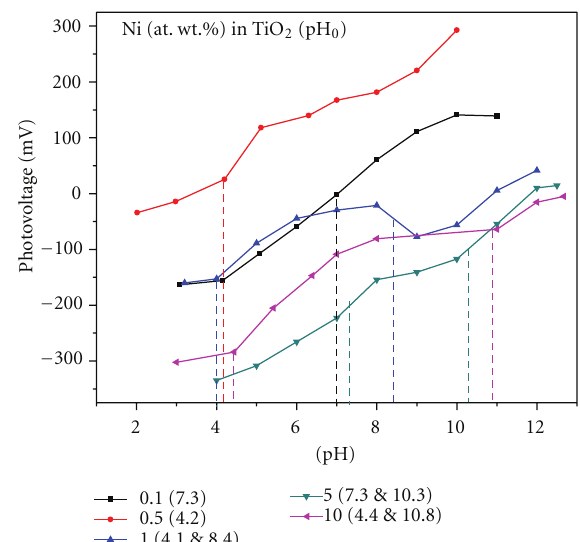
Figure 9: Dependence of photovoltage (V versus Ag/AgCl) of Ni- doped TiO 2 (Ni = 0.1, 0.5, 1, 5, and 10 at. wt.%) powders formed at 550 ◦ C for 6h on pH of electrolyte.